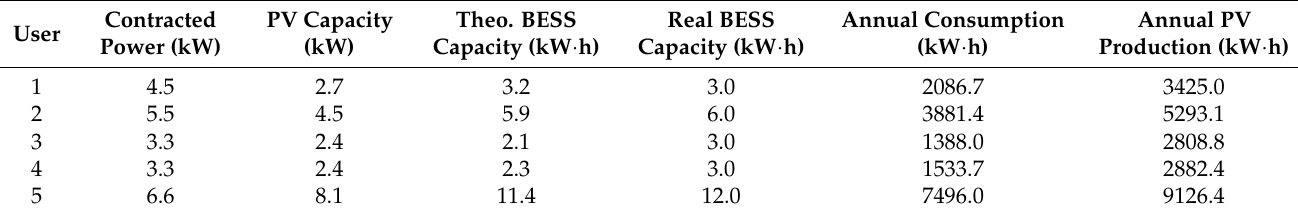
Table 1. Resulting data of user’s self-consumption